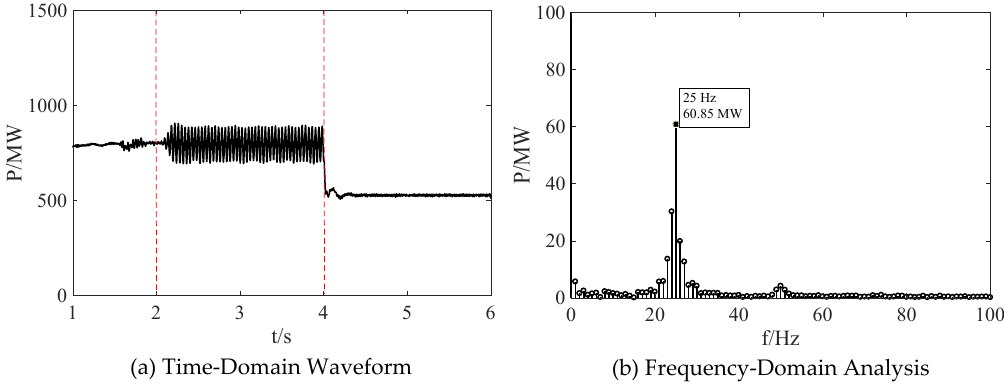
Figure 9. Observation results of transmission power in line Bus2-Bus1.